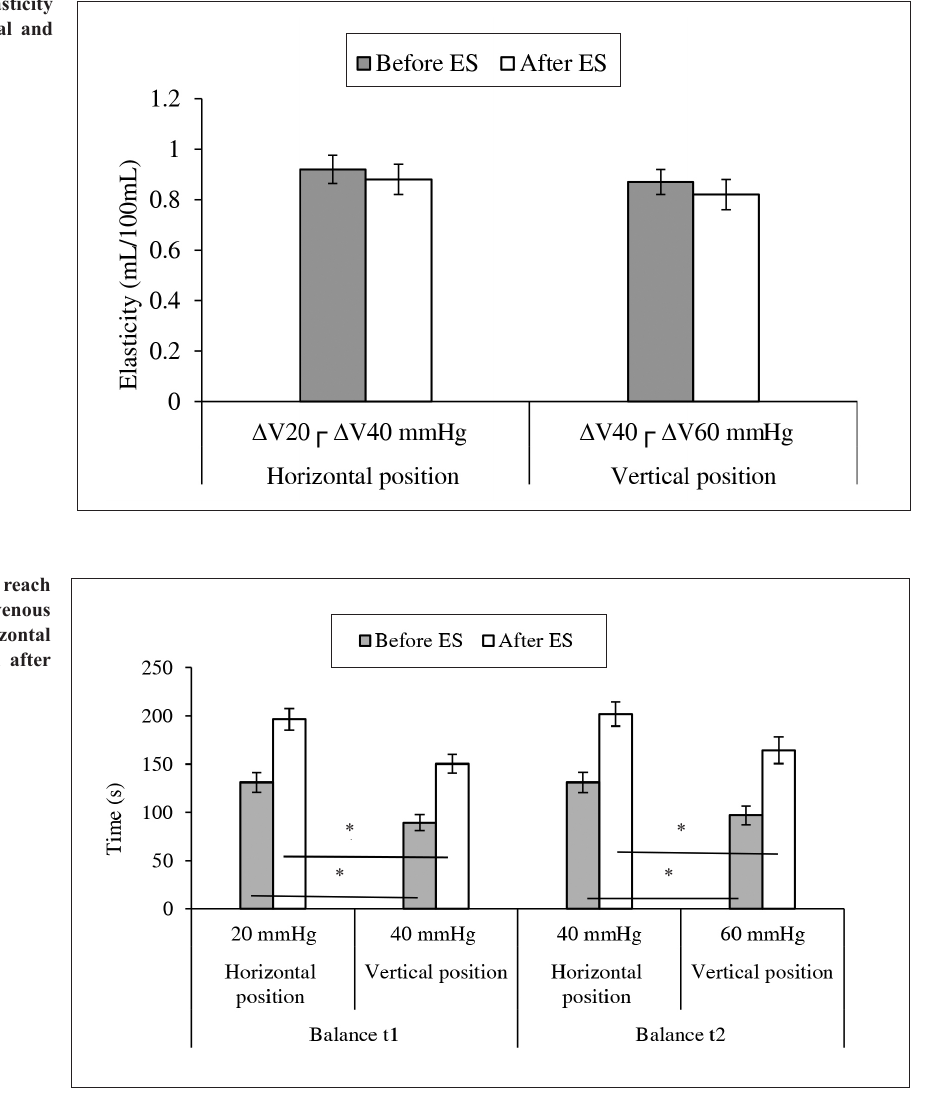
Figure 3. Change in venous elasticity (ml/100 ml) in the horizontal and vertical positions ( x ± Sx )